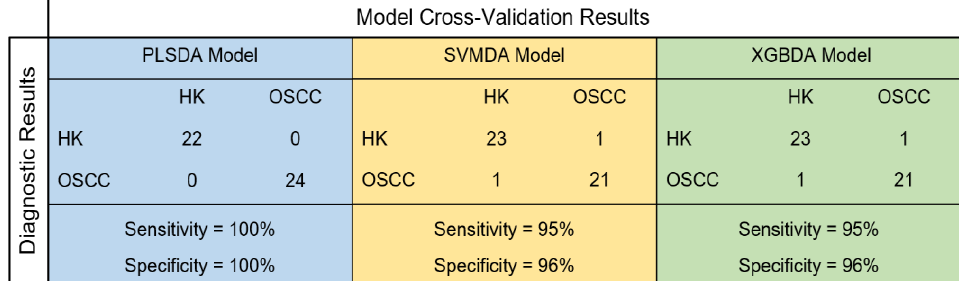
Figure 5. Cross-validation performances of three machine learning models for discriminating OSCC from HK samples. PLSDA — partial least square discriminant analysis, SVMDA — support vector machine discriminant analysis, and XGBDA — extreme gradient boosting discriminant analysis. Figure 6a shows the average modeling errors on the y-axis versus the number of latent variables (LV) on the x-axis for the PLSDA model. Both the average classification errors for the calibration (orange curve) and cross-validation (blue curve) were